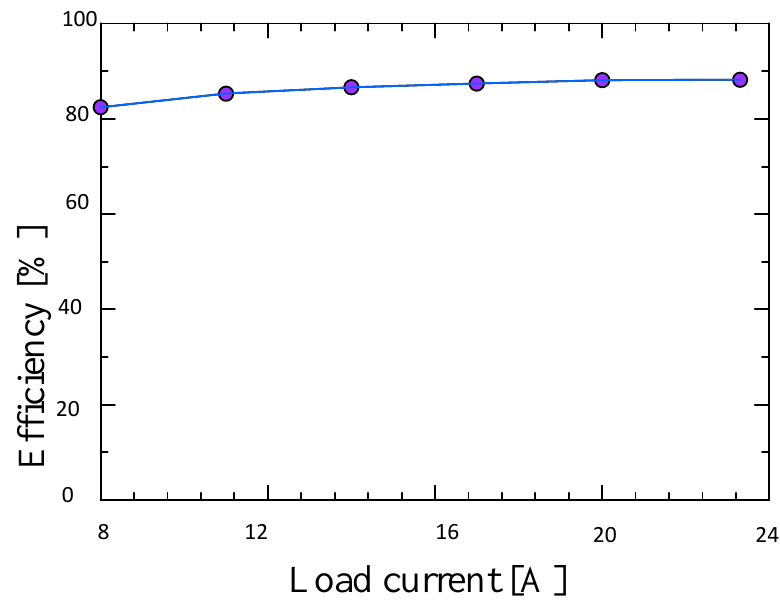
Figure 12. Load current–efficiency characteristics for loop control.